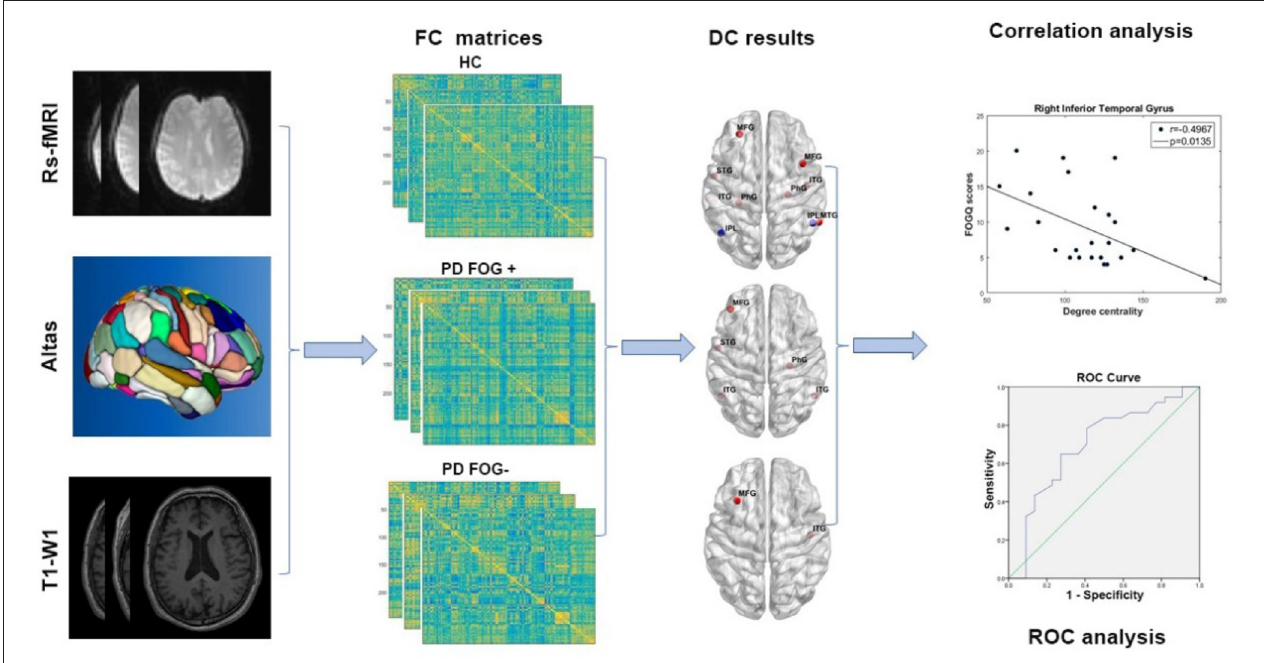
FIGURE 1 | The study procedure of image preprocessing, functional network construction, DC, correlation, and ROC analysis (rs-fMRI, resting-state functional magnetic resonance imaging; T1-WI, T1-weighted imaging; FC, functional connectivity; HC, healthy control; PD FOG + , Parkinson’s disease with freezing of gait; PD FOG − , Parkinson’s disease without freezing of gait; DC, degree centrality; ROC, receiver operating characteristic